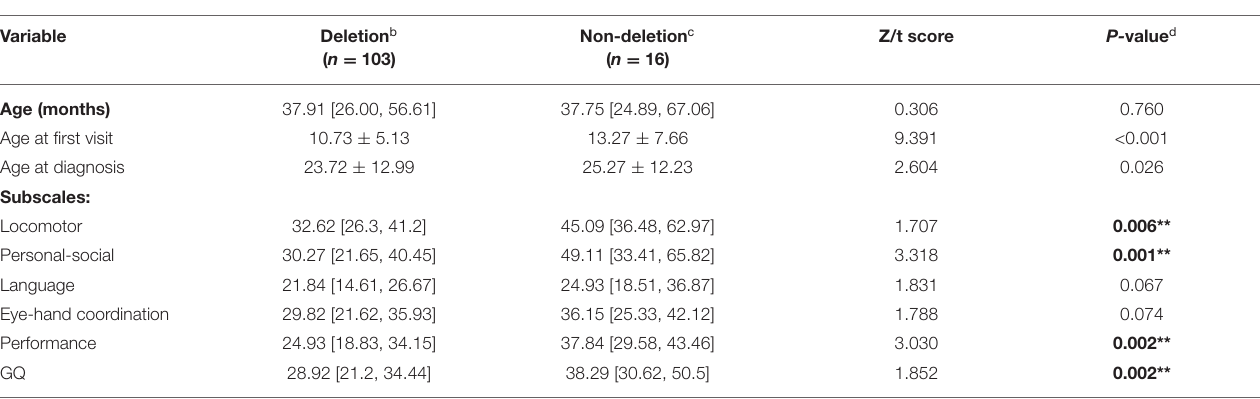
TABLE 3 | Correlation between neurodevelopment and molecular subtypes a